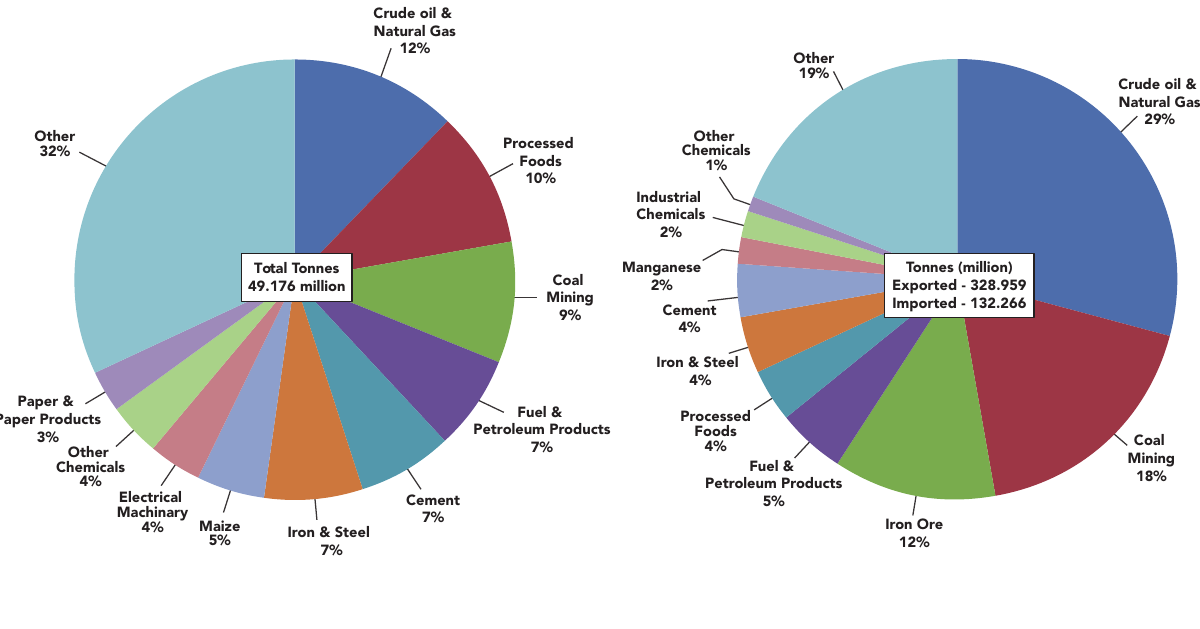
Figure 2: Comparison of commodities traded (percentage